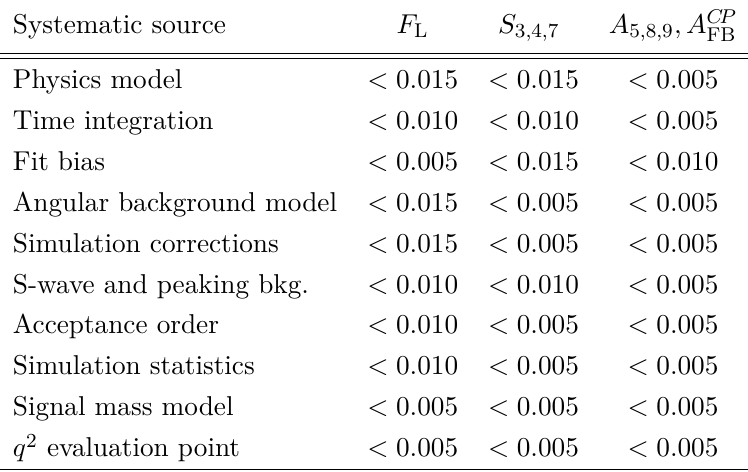
Table 2 . Sources of the systematic uncertainties associated with the angular observables. As the size of a systematic effect can vary strongly depending on the observable and q 2 region in question, only the magnitude of the largest systematic uncertainty across all regions, rounded up to the next multiple of 0.005, is